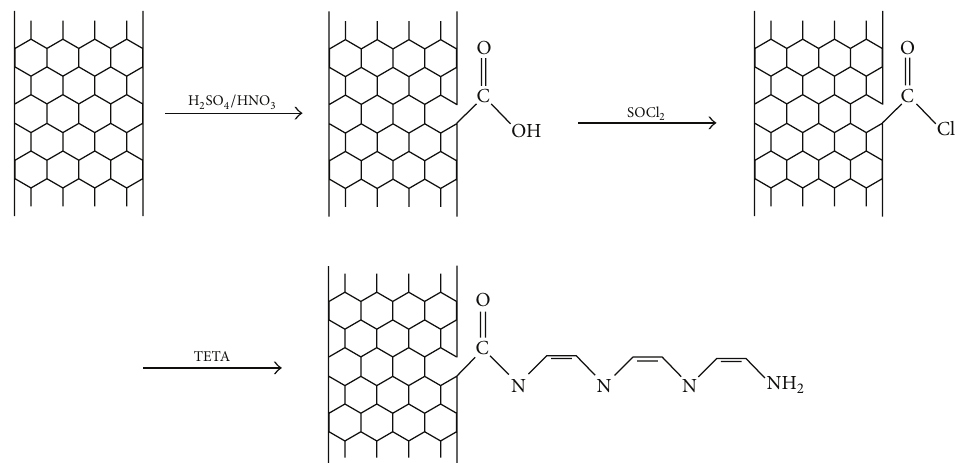
Figure 1: Preparation of amine functionalized